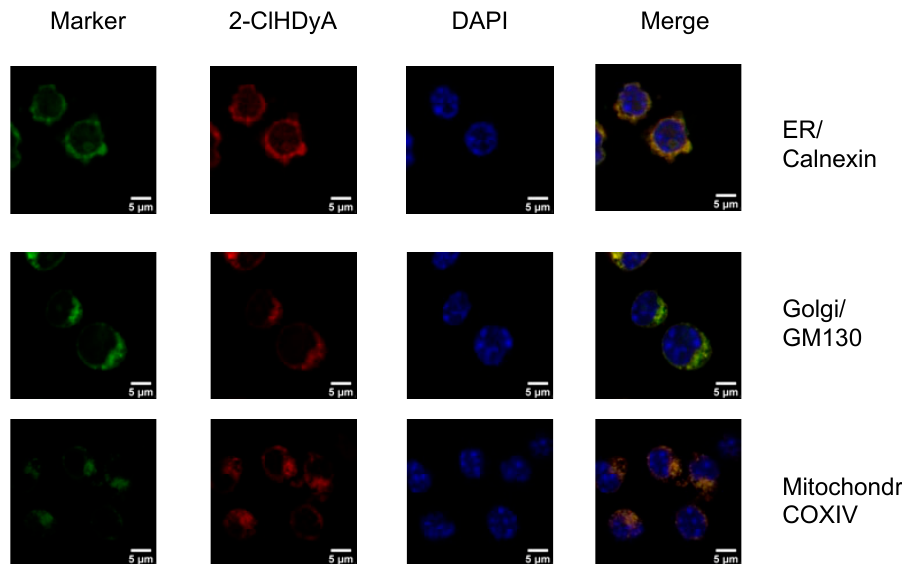
Figure 2. Subcellular localization of 2-ClHDyA in RAW 264.7 at 30 min. Cells were grown to con- fluence on sterile coverslips and treated with 10 µM 2-ClHDyA for 30 min. Cells were fixed with formalin, permeabilized with Triton X-100 and clicked with azide TAMRA (red). Cells were incubated with primary antibodies against GM130 (Golgi), calnexin (ER) and COXIV (mitochondria), then labeled with Alexa 488 labeled secondary antibodies (green). Cells were mounted in a DAPI-containing solution (blue) and imaged with a Leica SP5 microscope. All fluorescence was taken sim- ultaneously.